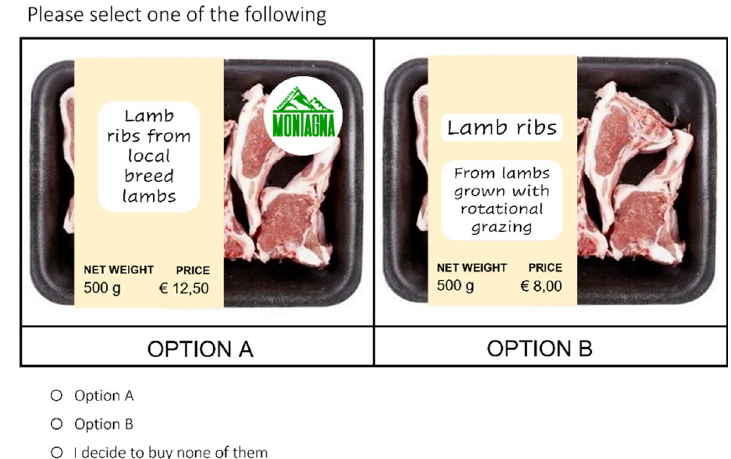
Fig. 1 Example of a choice set provided to